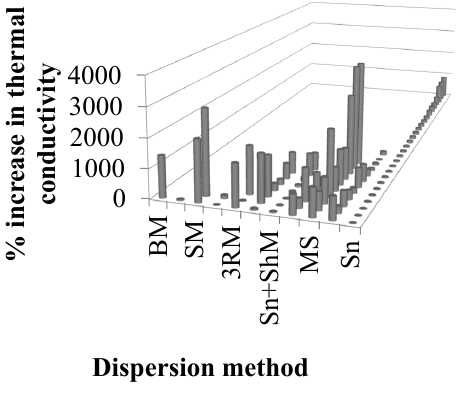
Figure 9. Percent increase in thermal conductivity as a function of dispersion method (see references in Table 2).